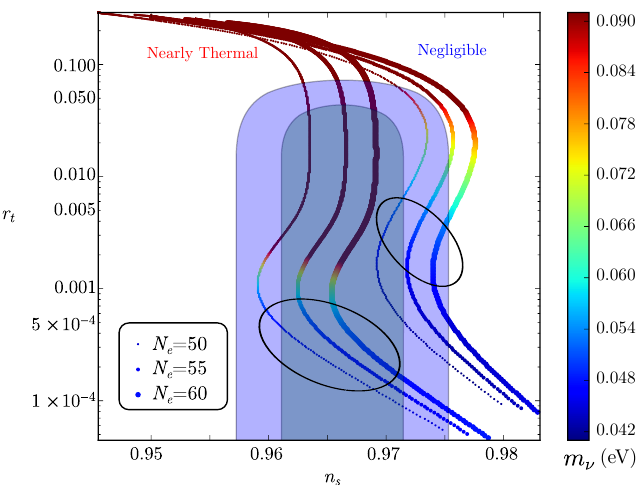
Figure 5 . Predictions for inflationary observables ( n s , r ) and the largest left-handed neutrino mass eigenstate, for V ( φ ) = λφ 4 , considering the two limiting cases where inflaton particles are nearly thermalized or have negligible occupation numbers at horizon-crossing of the relevant CMB scales. The blue contours correspond to the Planck TT,TE,EE+lowE+lensing +BK14+BAO 68% and 95% C.L. regions [71]. The ellipses highlight the parametric regions where the neutrino mass is in agreement with the experimental